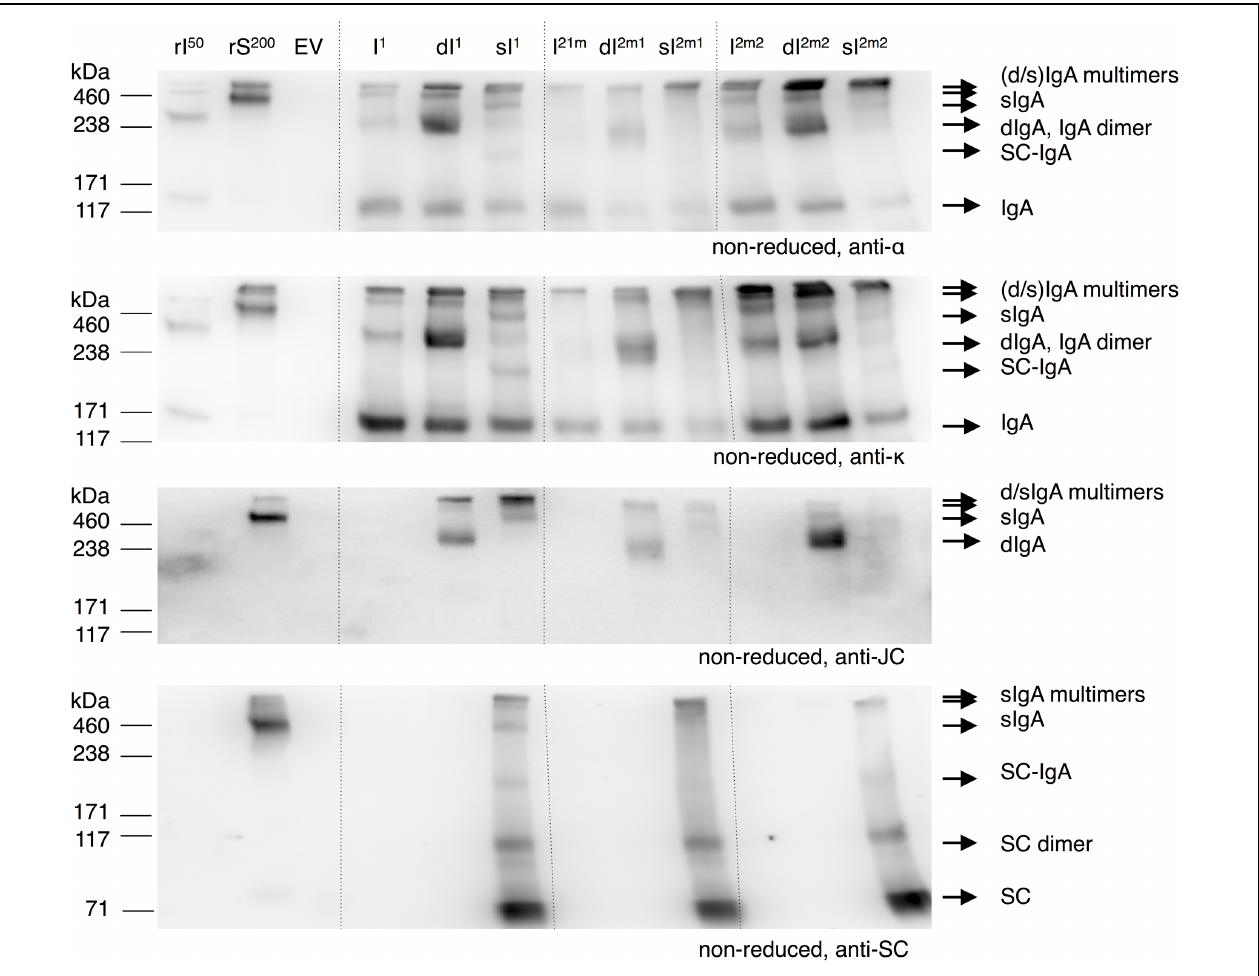
FIGURE 5 | sIgA assembly using multi-cassette expression vectors. Leaves were agro-infiltrated for the expression of IgA1 (I 1 ), 2m1 (I 2m1 ), or 2m2 (I 2m2 ) together with joining chain (dI) and secretory component (sI) using multi-cassette vectors and harvested 6 dpi. TSPs were extracted and 1 μ g was separated by SDS-PAGE under reducing conditions followed by visualization using protein specific antibodies as indicated. As controls 50 ng of recombinant IgA1 κ (rI 50 ) and 200 ng purified sIgA (rS 200 ) and an EV sample were